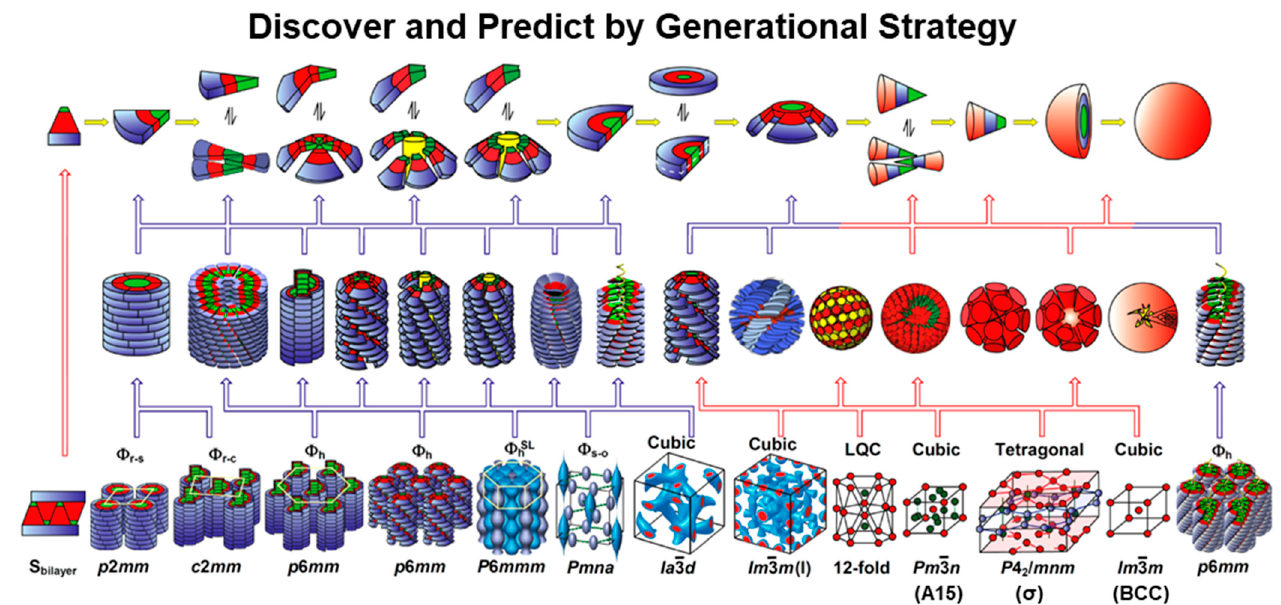
Figure 2. Structural and retrostructural analysis of supramolecular assemblies formed via the self- assembly and self-organization of dendrons help to discover and predict by generational strategy [60]. The Figure was adapted and modified from [60]. Reproduced with permission from [60]. Copyright © 2009, American Chemical Society.